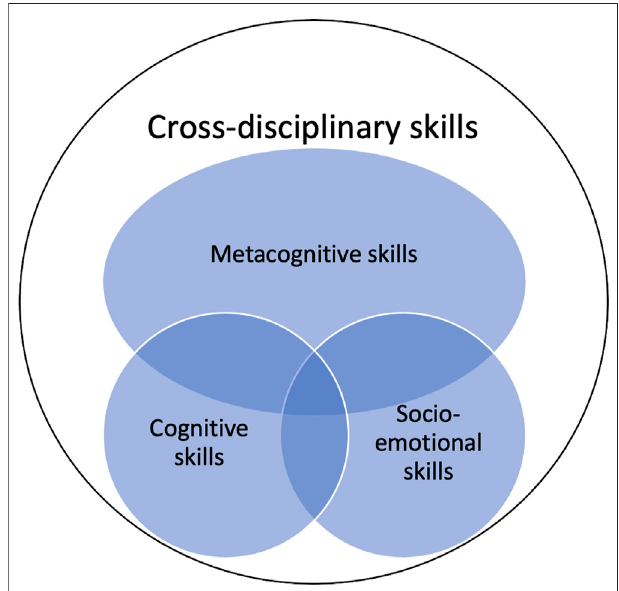
FIGURE 1 | Modelling of cross-disciplinary